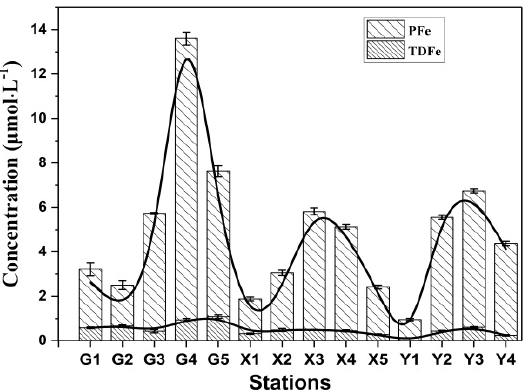
Figure 6. The concentrations of different Fe fractions in the main coastal rivers to Yantai Sishili Bay.